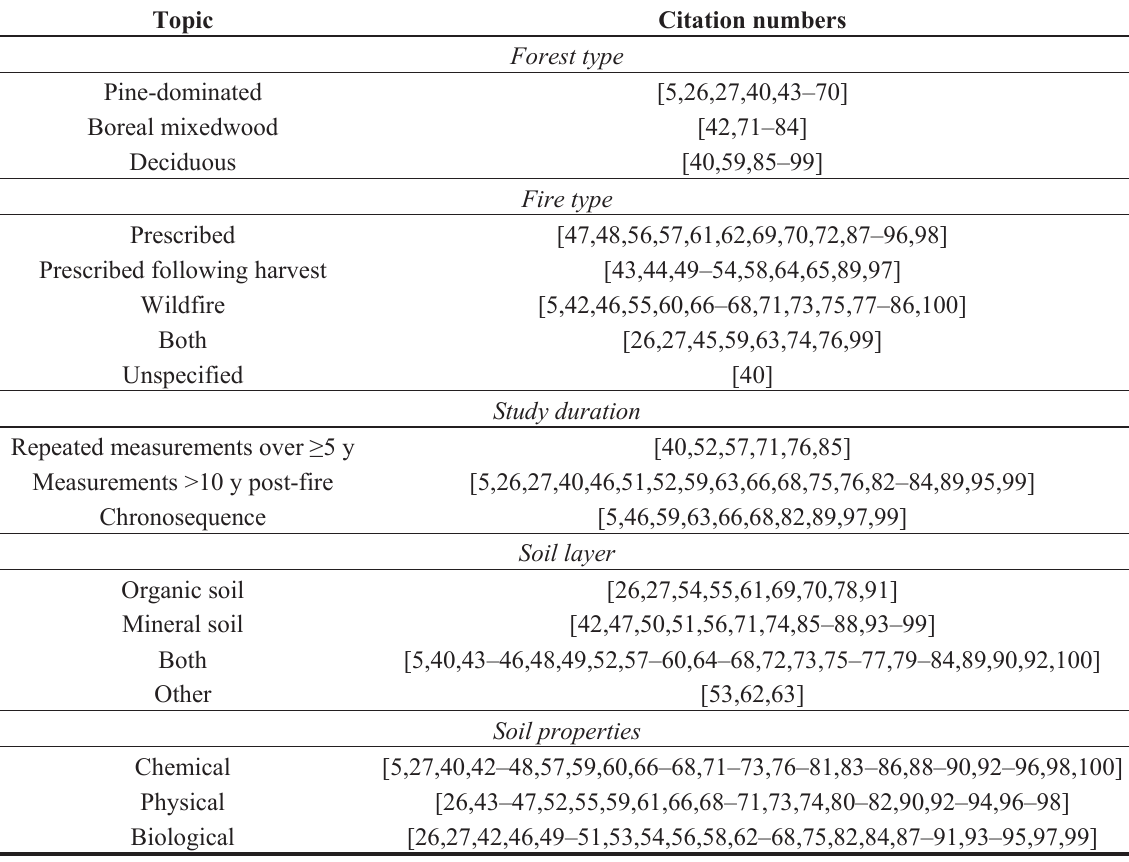
Table 2. Index to citation numbers for studies addressing fire effects on soils in the Lake States region. Full citations are given in References. Summary tables for studies indexed in this table are presented in alphabetical order by author last name in Supplementary